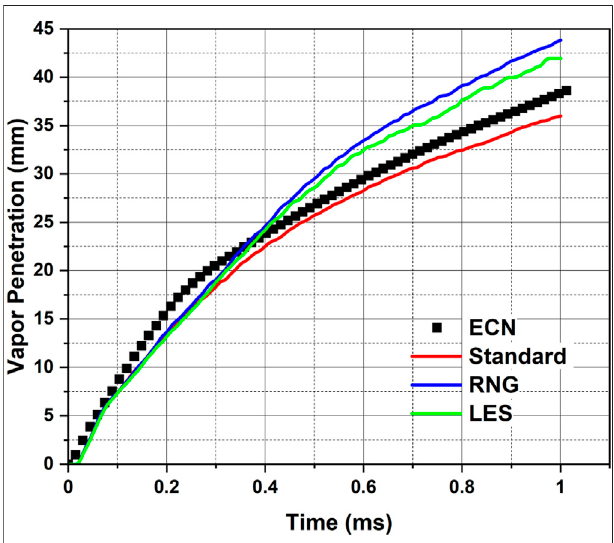
FIGURE 5 | Comparison of model predictions of vapor penetration with the latest data measured by Sandia National Laboratories, available on ECN (ECN,2022b)[Standardk – ε turbulencemodelusedwith C ε 1 =1.44,RNGk – ε and LES Dynamic Structure; B C bl = 2.5, cone-angle 25 ° , plume 1 = 5, targeting angle 35 ° ].